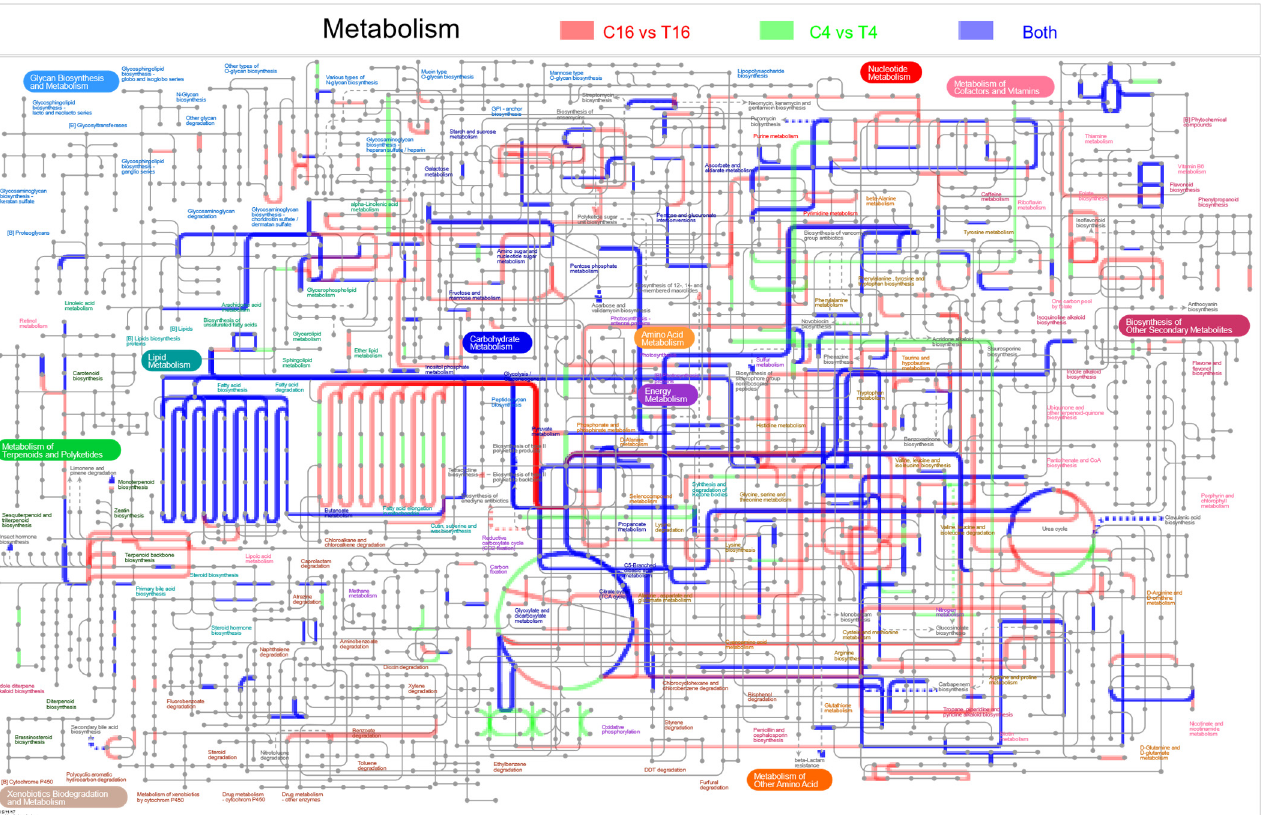
Figure 7. Global metabolic pathways of F. pseudograminearum differently expressed genes (DEGs) between pure cultures and co-cultures with YB-185. Pathways with DEGs unique to 4 and 16 h are highlighted in green and red, respectively, while DEGs at both 4 and 16 h are highlighted in blue. C4 and T4 samples are RNAs of F. pseudograminearum cultured for 4 h without or with YB-185, respectively, and C16 and T16 samples are RNAs of F. pseudograminearum cultured for 16 h without or with YB-185, respectively.